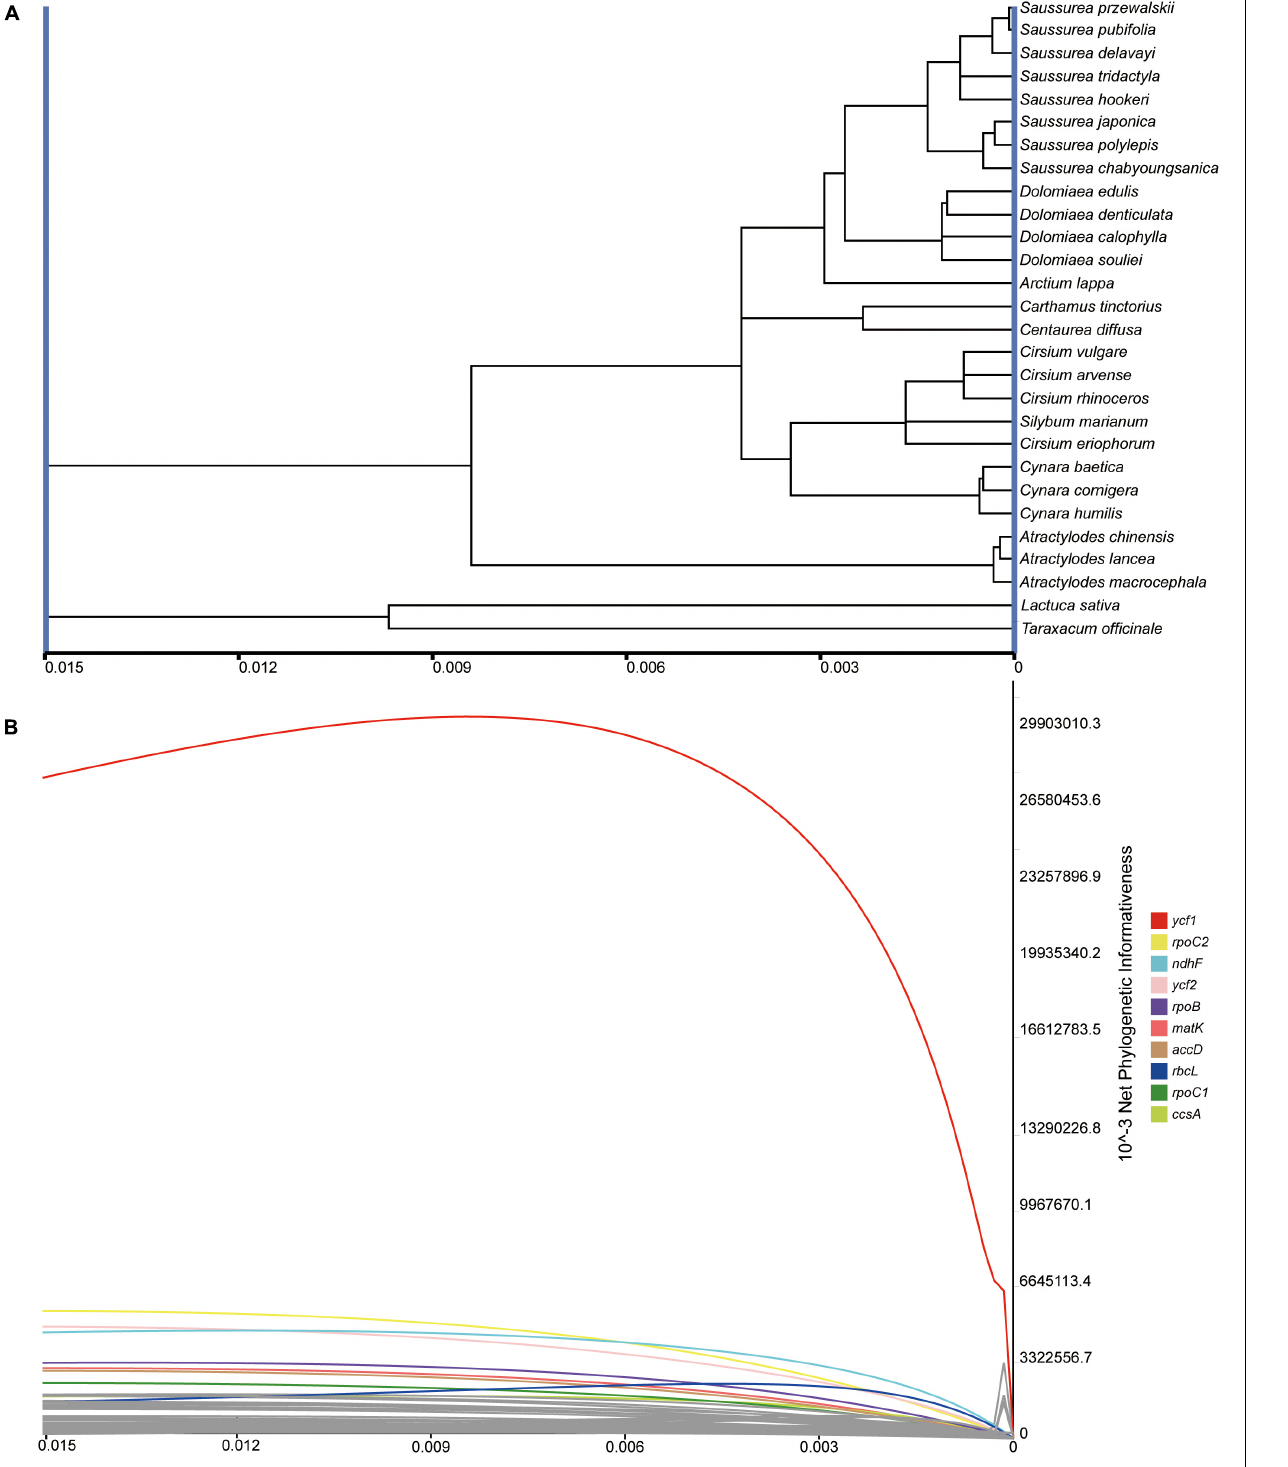
FIGURE 7 | Phylogenetic net informativeness profiles of 79 PCGs of Cardueae estimated in PhyDesign (Lopez-Giraldez and Townsend, 2011). (A) The ultramteric tree of Cardueae converted in the dnamlk program in PHYLIP (Felsenstein, 1989). (B) Net phylogenetic informativeness profiles for 79 PCGs. Ten genes with the greatest informativeness are color-coded and indicated at the right. X - and Y -axes represent relative-time and net phylogenetic informativeness, respectively.